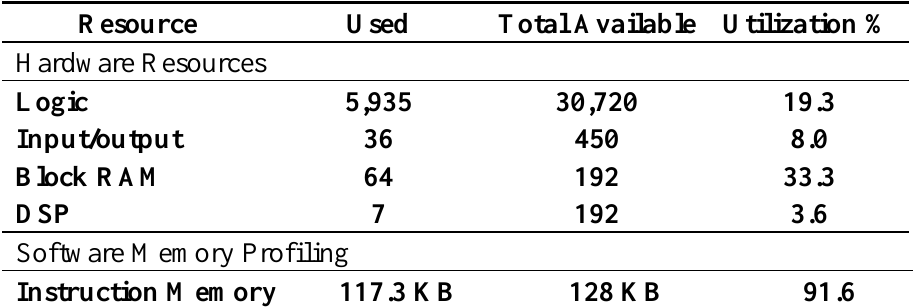
Table 2. Hardware Resources and Memory